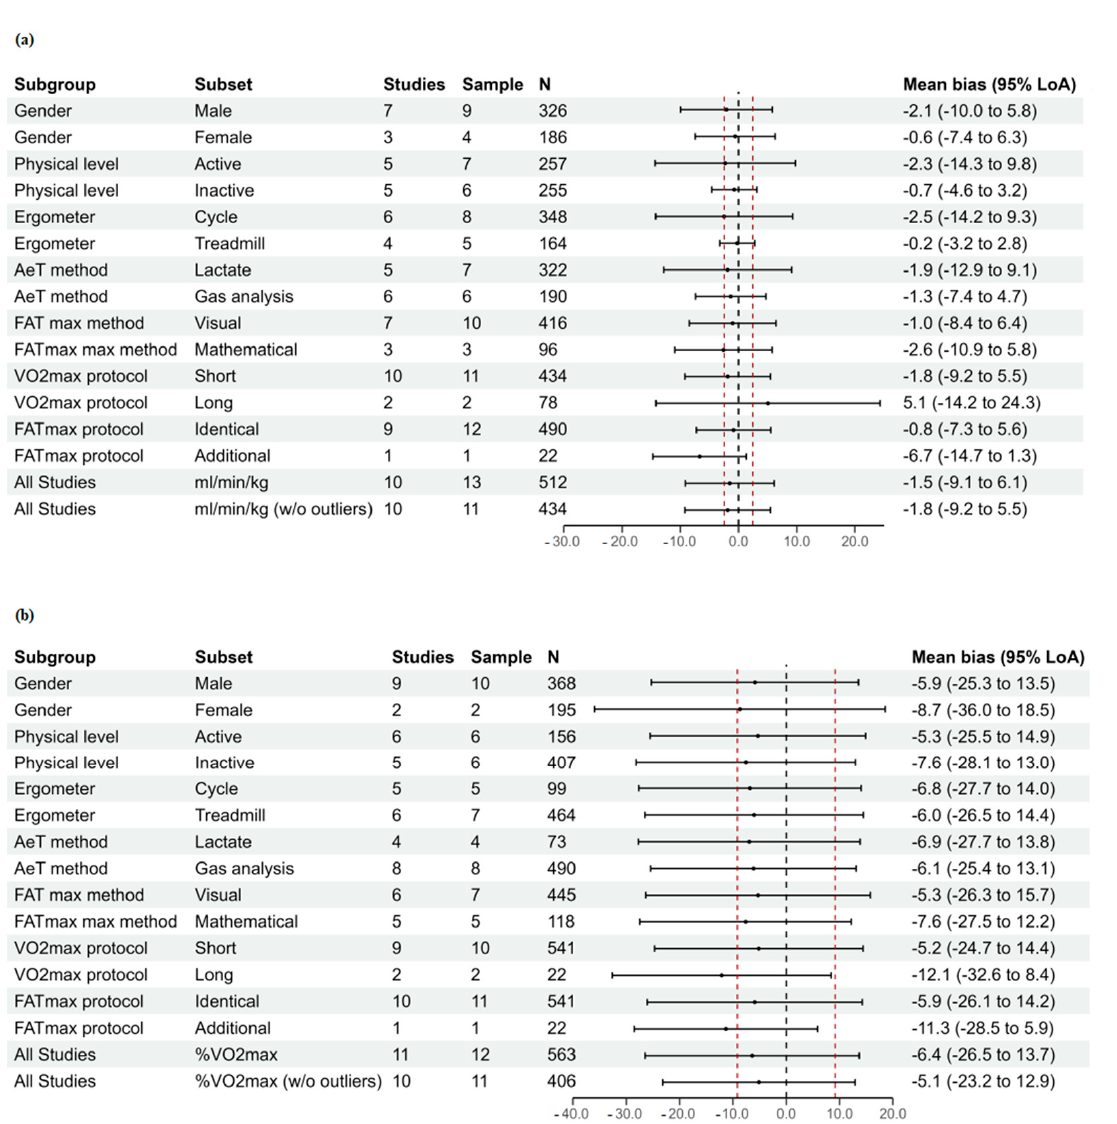
Figure 3. Forest plots of the pooled 95% limits of agreement (LoA) and mean bias with the estimated FAT max zone (red dotted line a priori calculated to be ± 4.89/2 ( ± 2.44) mL/kg/min and ± 18.34/2 ( ± 9.17) %VO 2max , see Supplementary Material Section S1) for exercise intensities expressed as mL/kg/min ( a panel) and as %VO 2max ( b panel) further divided into subgroups. NOTE: Sample: number of samples for each study. All study samples represent estimates including all studies; w/o outlier represents estimate performed excluding potential outliers.